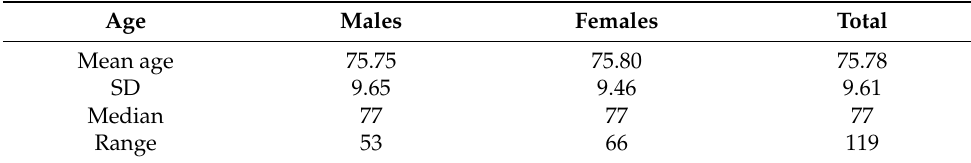
Table 1. Demographic characteristics of the followed